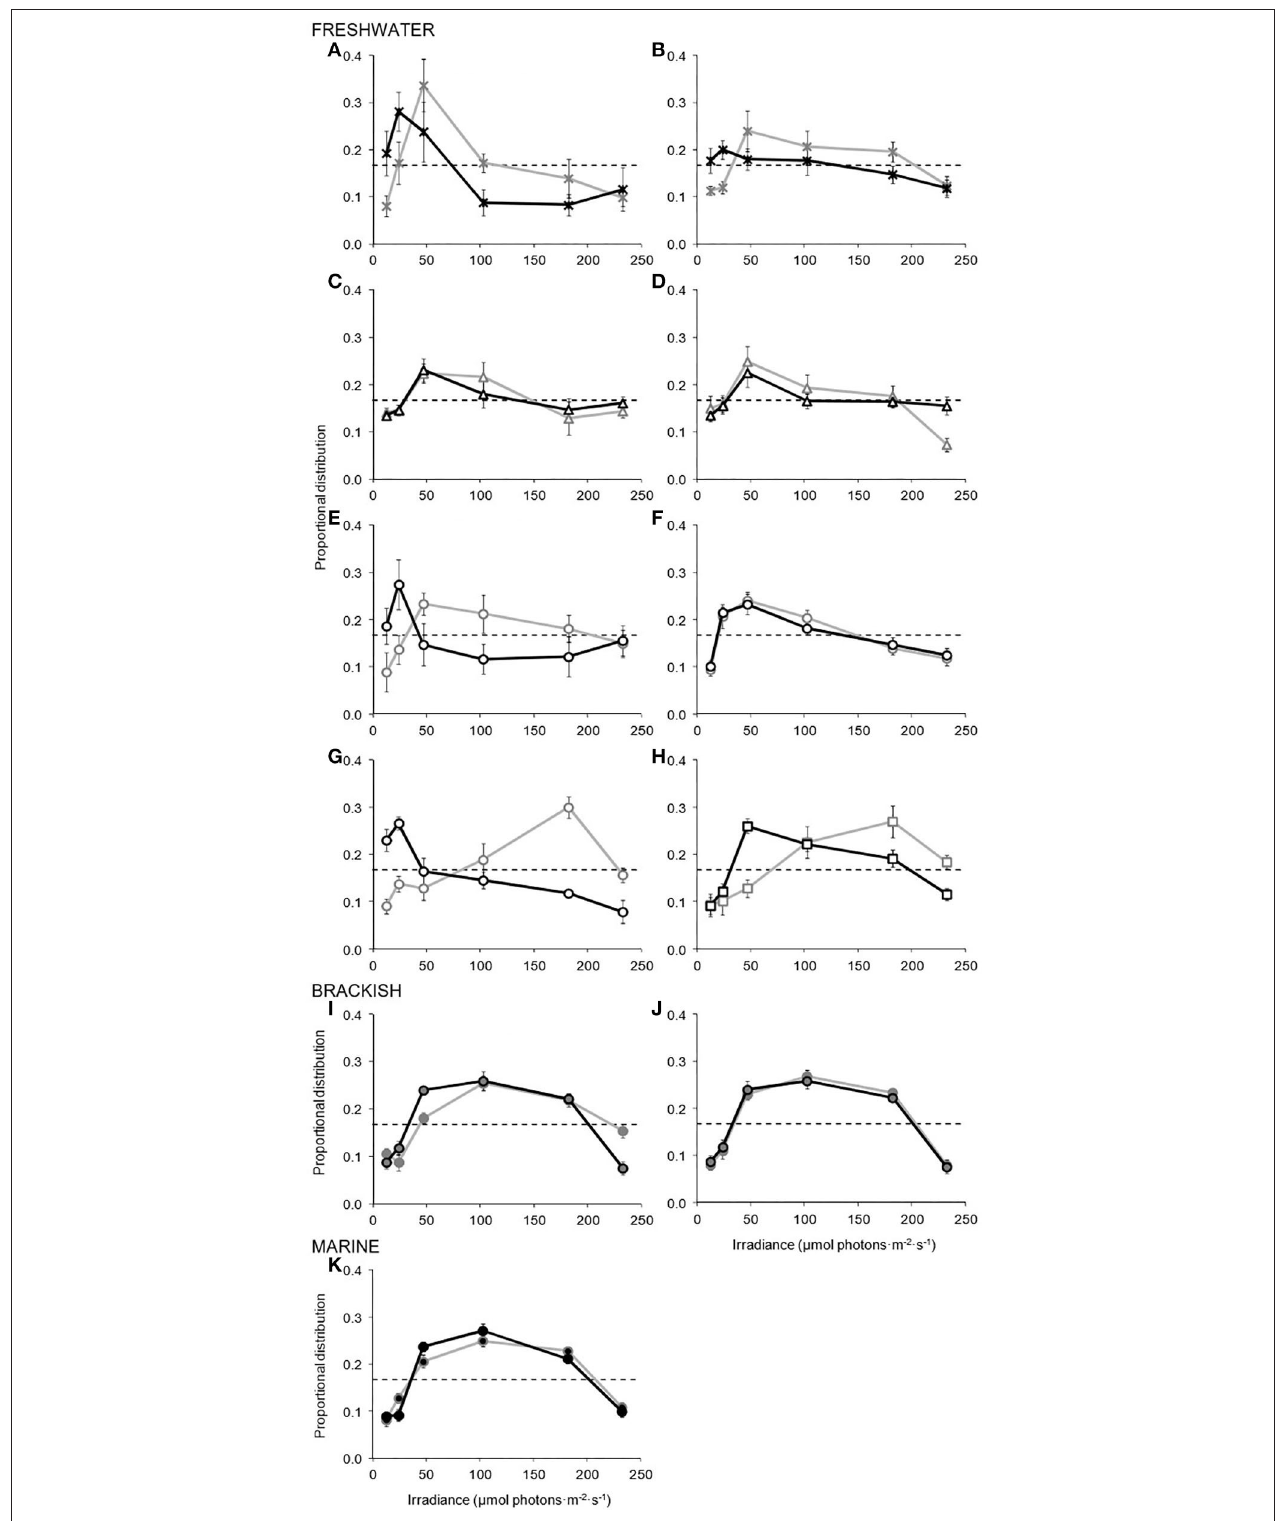
FIGURE 1 | Population response curves showing the behavioural response of the 11 species of Chlamydomonas (A–K) , cultured at low light (LL, black curves and symbol outlines) and high light (HL, grey curves and symbol outlines), when exposed to a gradient of photon irradiance within a preference chamber. The